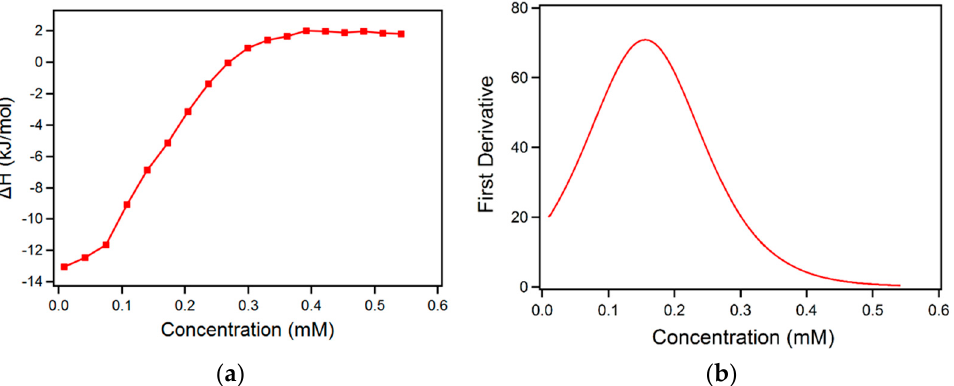
Figure 3. ( a ) Δ H of injection per mole of injected R95D90 in aqueous solution plotted as a function of the R95D90 concentration in the calorimeter cell; ( b ) first derivative of the Δ H vs. surfactant concentration.